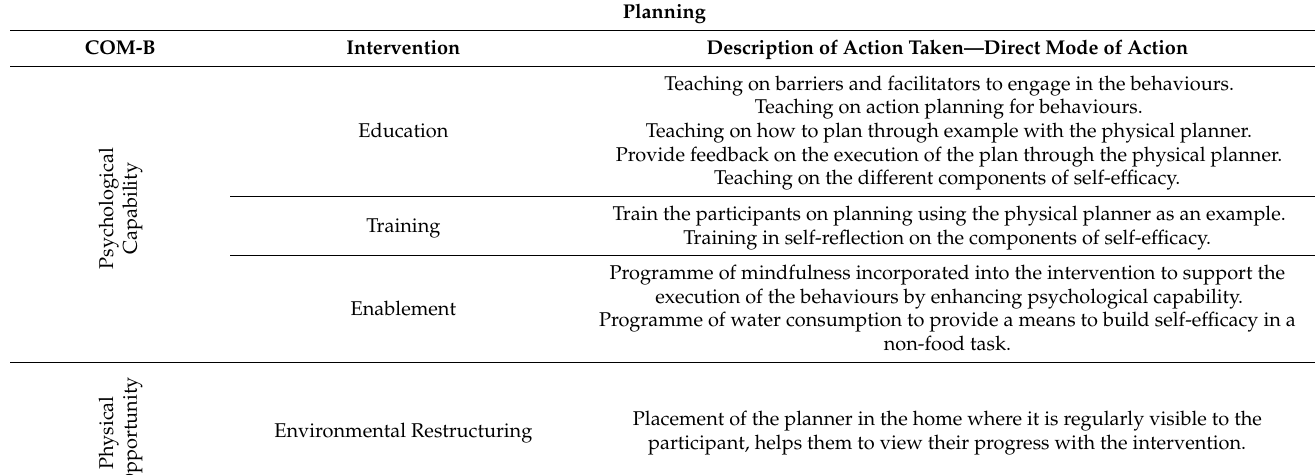
Table 1. Action to be taken to support the relevant intervention functions associated with the three dimensions of the COM-B model for the barrier/facilitator theme planning.